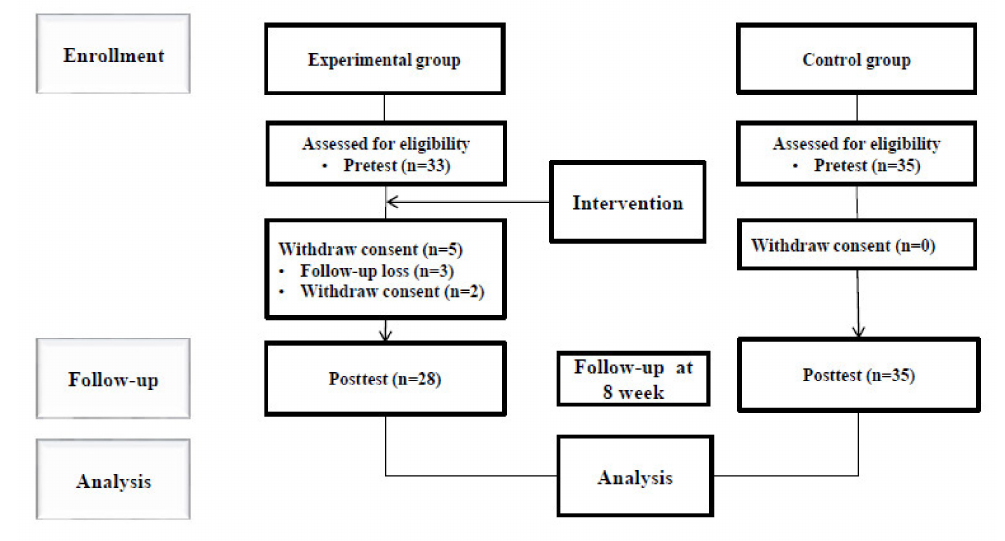
Figure 1. Consort flow